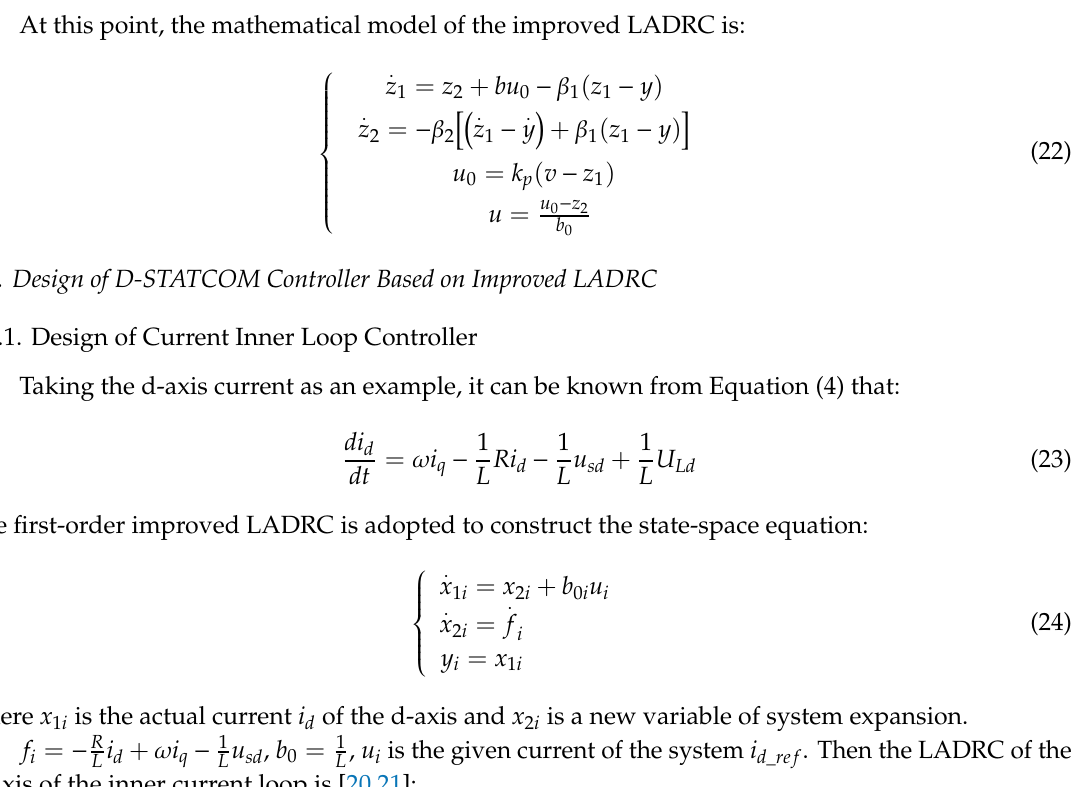
Figure 4. The structure block diagram of the improved LADRC.